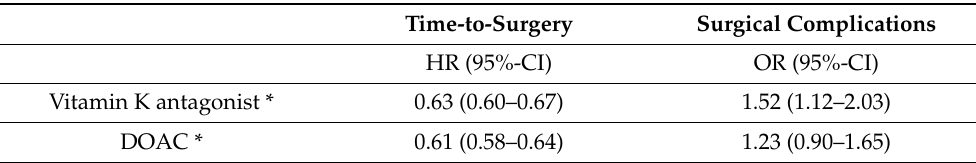
Table 3. Adjusted Cox or logistic model to evaluate the influence of therapeutic anticoagulation on surgical-free survival or surgical